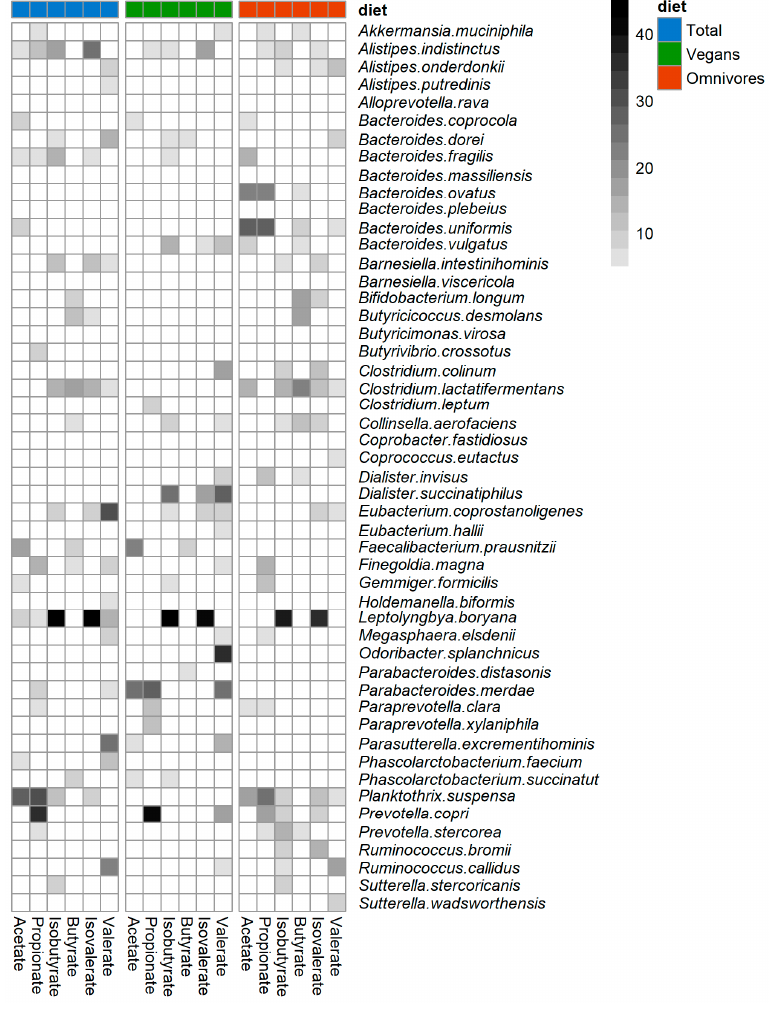
Figure 5. Predictive bacteria for selection model. Grid cells shows the mean square error (MSE%) values of bacteria with an MSE% value >2 from the selection model. The selection model was computed using S/BCFA as outcomes and the most abundant bacteria (50% of participants and >100 reads) as exposure variables adjusted for age, sex, BMI, physical activity, smoking status, stool pH, protein, fat, carbohydrates, fiber, and alcohol intake. The darker the MSE% value, the more important a bacterial species is for the prediction of the respective S/BCFA.